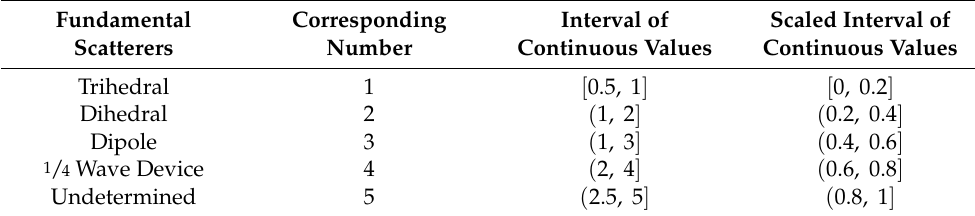
Table 3. Proposed representation of PolSAR cells based on the scaled interval of continuous